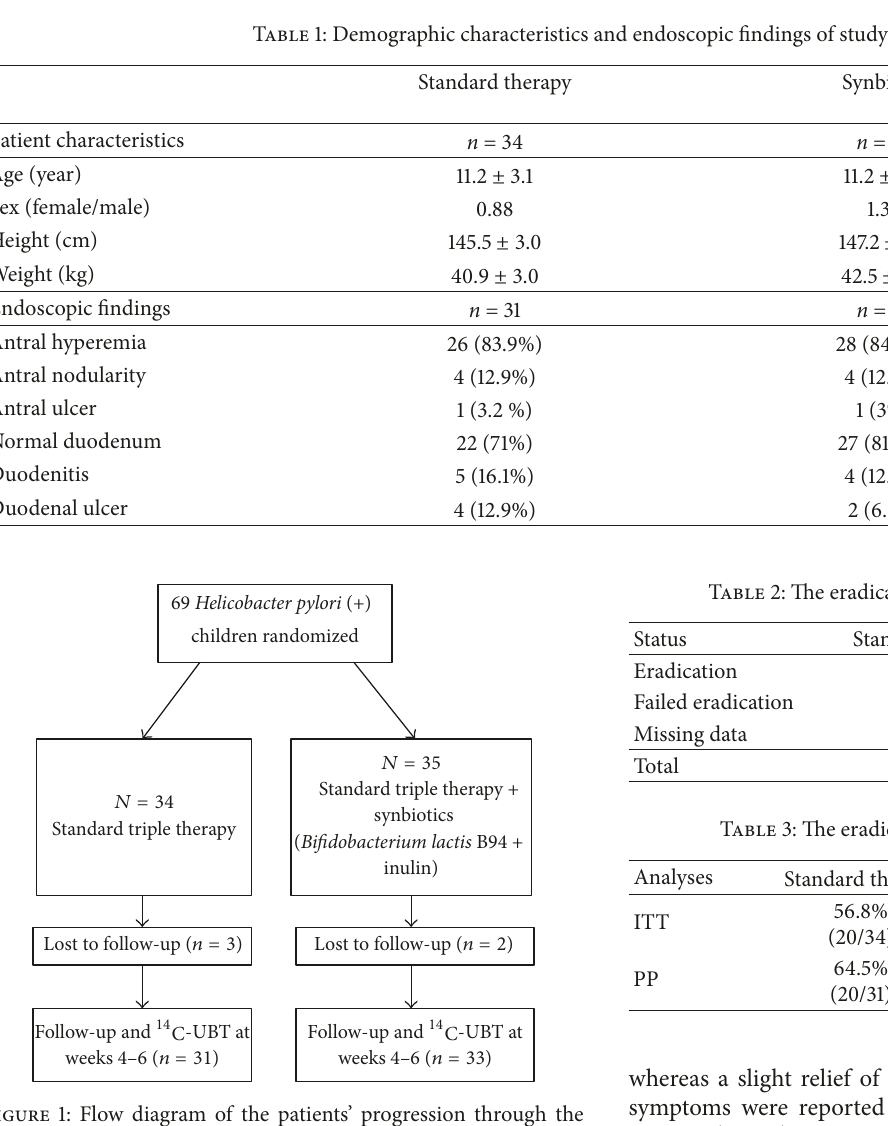
Figure 1: Flow diagram of the patients’ progression through the study. 14 C-UBT: carbon-14 labelled urea breath test.